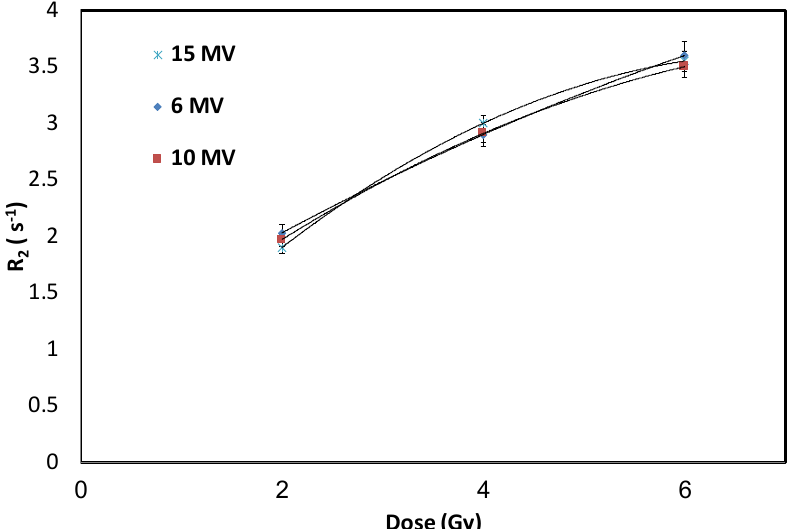
Figure 5. R 2 of gel with 500 mM CaCl 2 for various radiation energies. Error bars are the 2 σ of R 2 values.